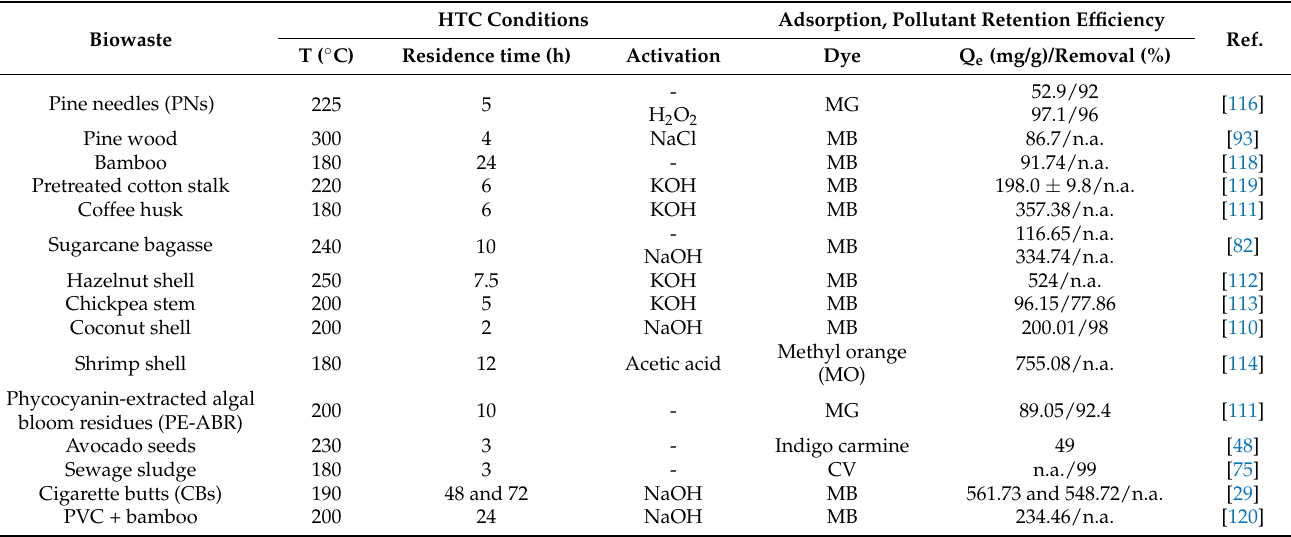
Table 1. HTC conditions and adsorption performance of HC for dyes removal for wastewater